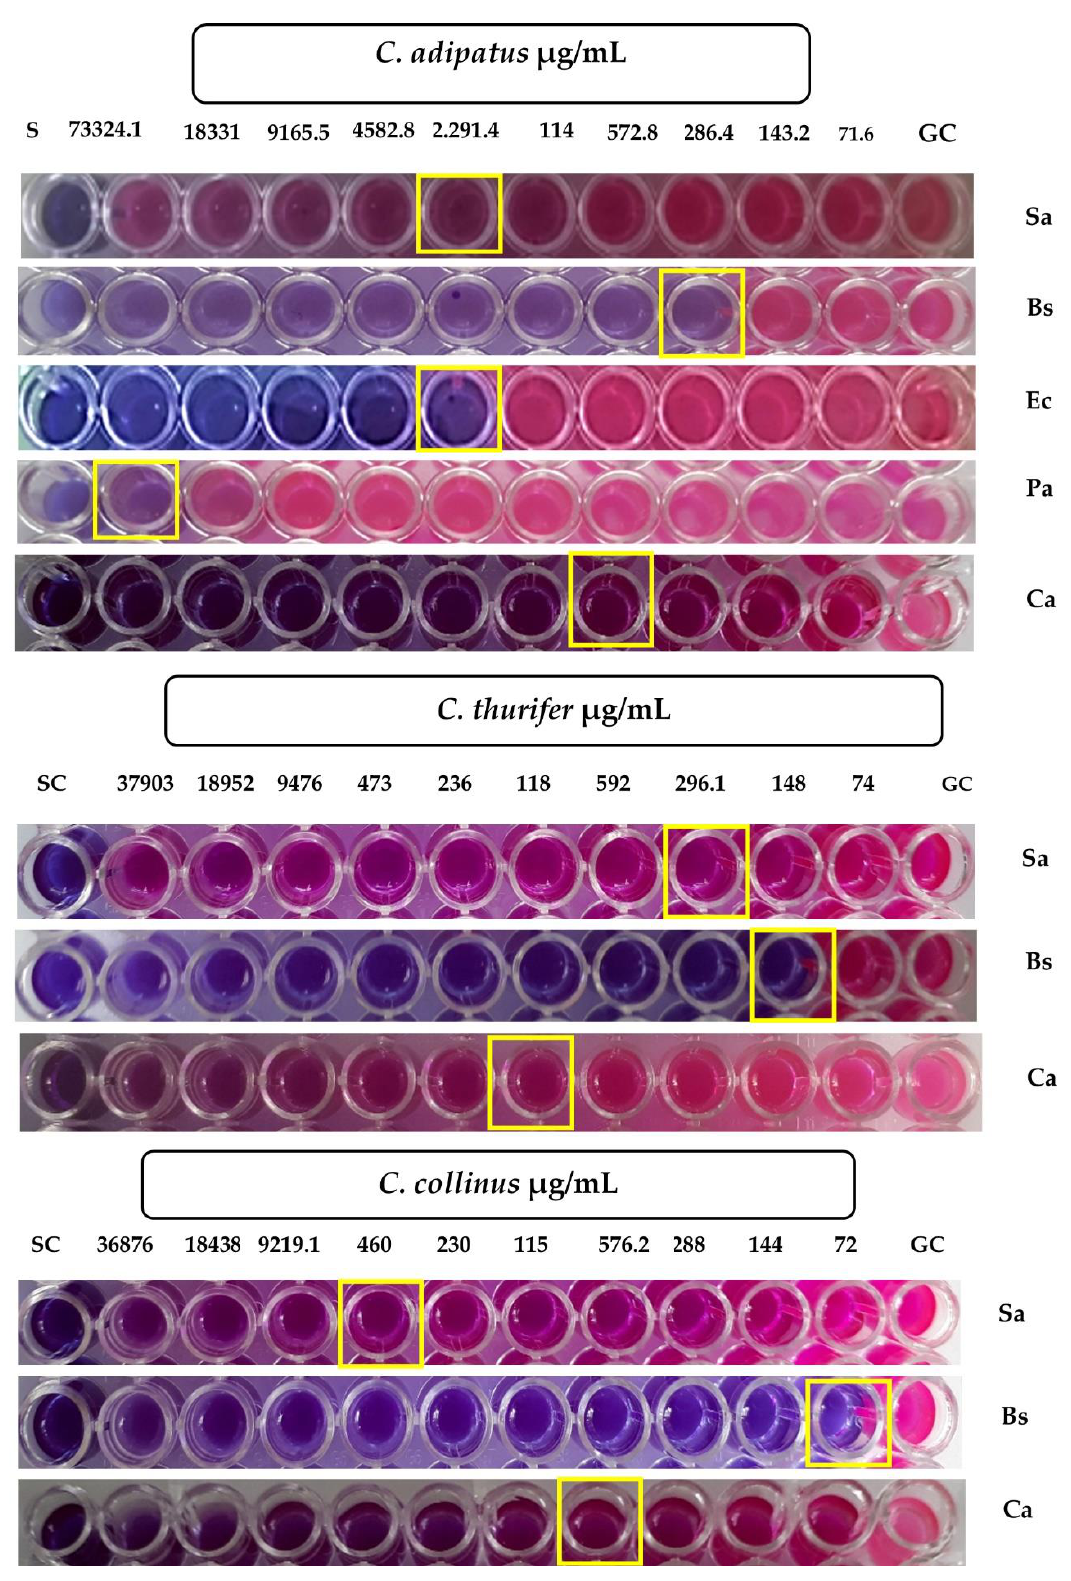
Figure 3. Determination of the minimum inhibitory concentration of the essential oil and standard drugs. SC (Sterility Control), GC (Growth Control), Sa ( S. aureus ), Bs ( B. subtilis ), Ec ( E. coli ), Pa ( P. aeruginosa) , Ca ( C. albicans ). In B. subtilis , other Croton species presented good activity such as: C. zambesicus steam and leaves (MIC = 16 µ g/mL) [17], C. heliotropiifolius aerial parts (MIC = 62.5 µ g/mL) [44], C.